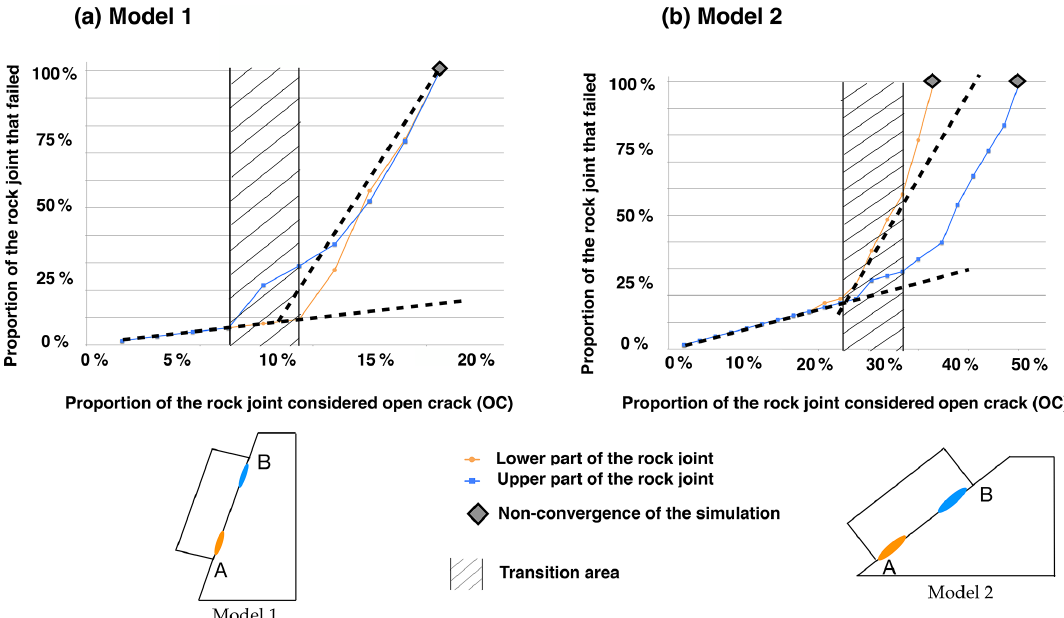
Figure 5. Propagation of rock bridge failure for models 1 and 2 considering Scenario 2. Intentionally introduced OC contacts are located in the upper part of the joint (blue curve) or in the lower part of the joint (orange curve). The proportion of the rock joint that failed is defined as a ratio between the number of failed contacts (OC + RBF) and the total number of contacts (OC + RB + RBF).